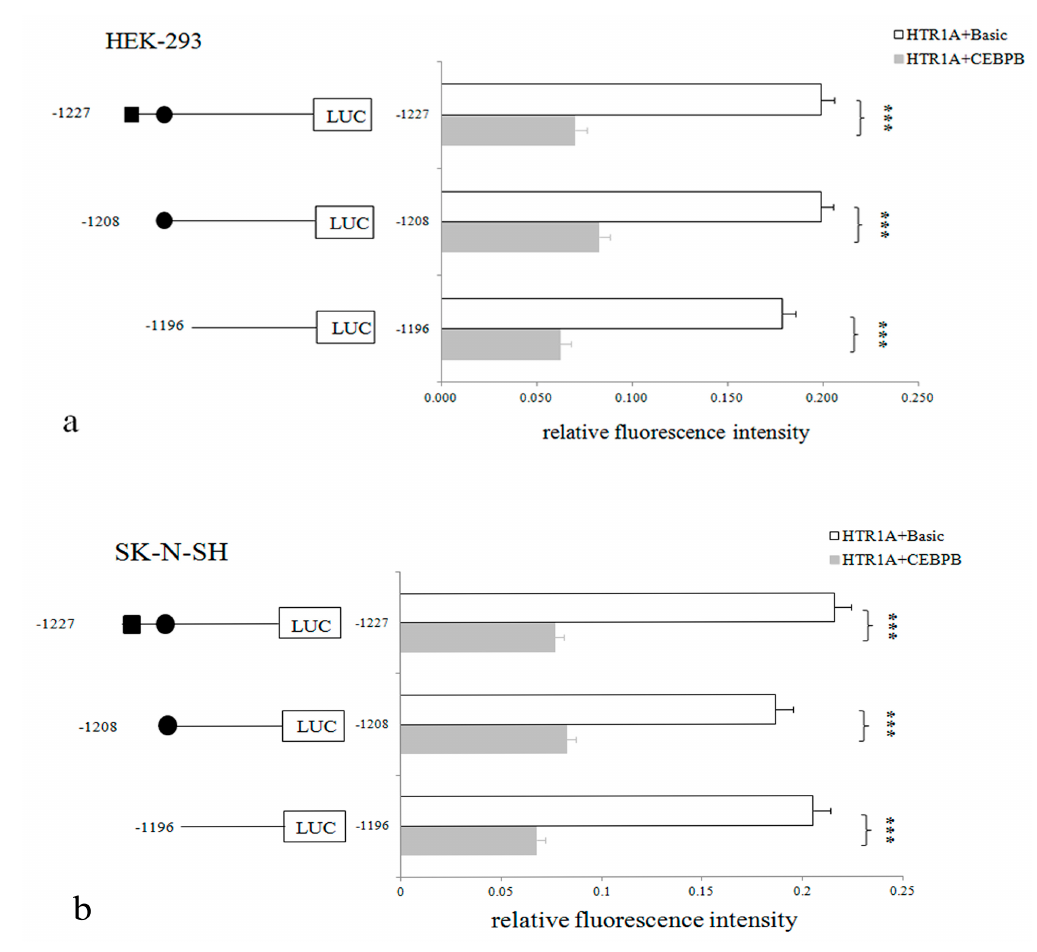
Figure 4. ( a ) E ff ect of CEBPB on the relative fluorescence intensity in two cell lines, ( b ) The Figure 4. Effect of CEBPB on the relative fluorescence intensity in two cell lines ( a ), ( b ) The rectangle and circle rectangle and circle represent the sequence positions identified by CEBPB, LMX1B, represent the sequence positions identified by CEBPB, LMX1B, respectively. In HEK-293 and SK-N-SH cells,